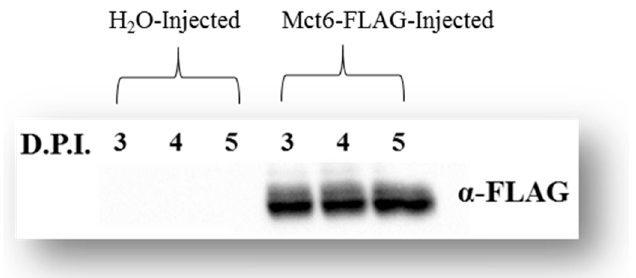
Figure 1. Western blot analysis demonstrating positive protein expression of Mct6-FLAG (~52 KDa) in transfected oocytes 3-5 D.P.I. using anti-FLAG ( α -FLAG) primary antibody (D.P.I.: days post-injection).